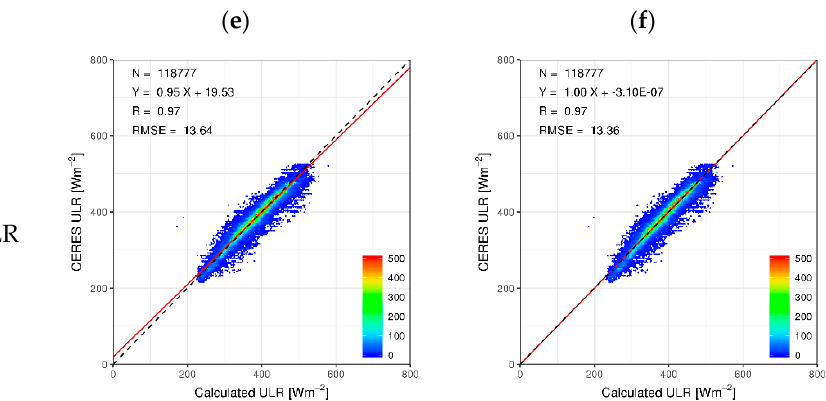
Figure 5. Density scatter plot of calculated longwave radiation components and CERES longwave radiation before ( a , c , e ) and after ( b , d , f ) calibration. Here, N is the total number of samples used for verification. The black dash line is the 1:1 line and the red line is the regression line. The unit of RMSE is Wm − 2 .